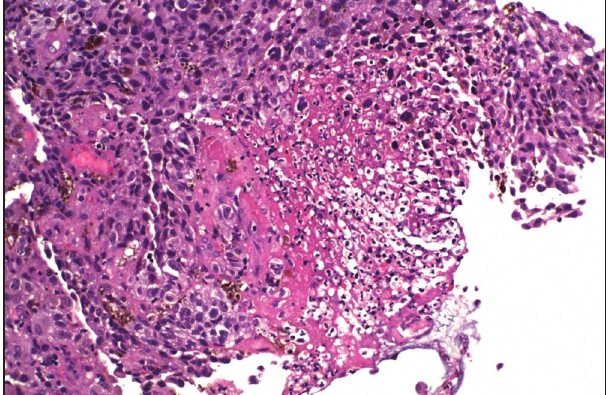
Figure 3) Poorly differentiated cell population with necrosis and ulceration (hematoxylin and eosin stain, original magnification ×200)